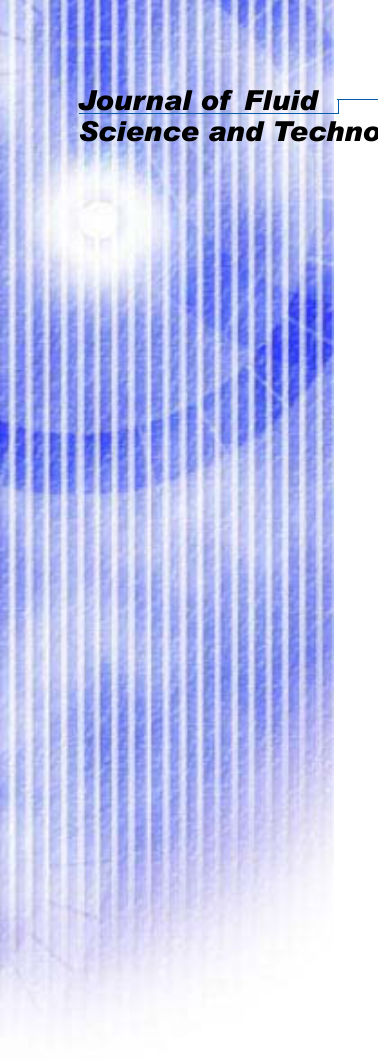
Fig.12 Distributions of Fig.13 Distributions of